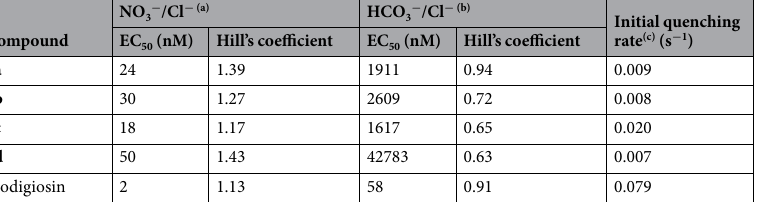
Table 2. Anion transmembrane transport facilitated by 1a - d and prodigiosin. a LUV loaded with 489 mM NaCl dispersed in 489 mM NaNO 3 (5 mM phosphate buffer, pH 7.2). b LUV loaded with 451 mM NaCl dispersed in 150 mM Na 2 SO 4 (20 mM phosphate buffer, pH 7.2) upon addition of a NaHCO 3 pulse to make the external bicarbonate concentration 40 mM. c LUV loaded with 102.2 mM NaNO 3 dispersed in 102.2 mM NaNO 3 (20 mM